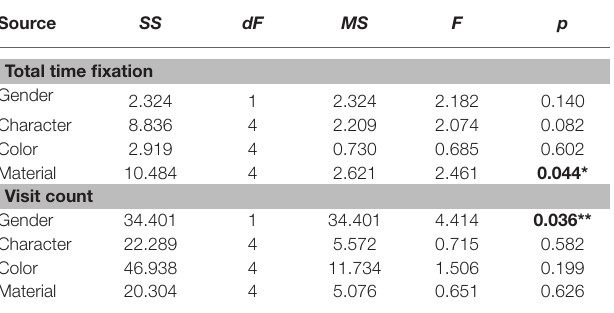
TABLE 2 | Statistical result of MANOVA for independent variables for toys. TABLE 3 | Analysis of the first four and last four dwells in each trial in the 8-AFK